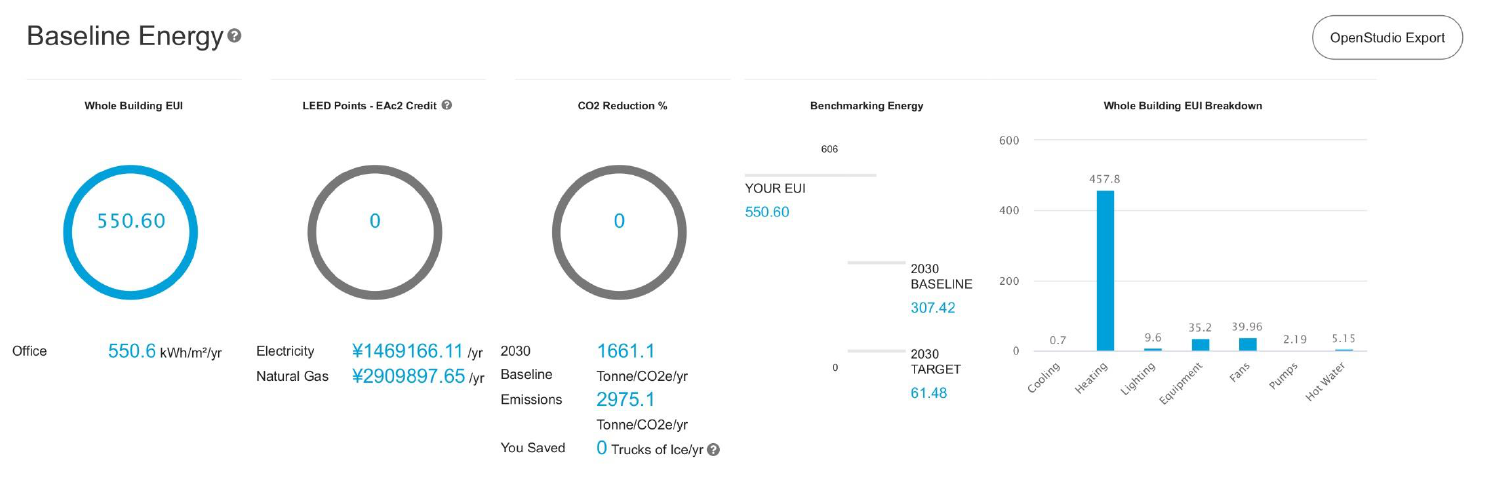
Figure A36. Zone 6-B Ordos, Nei Menggu (post-COVID-19 84% scenario).